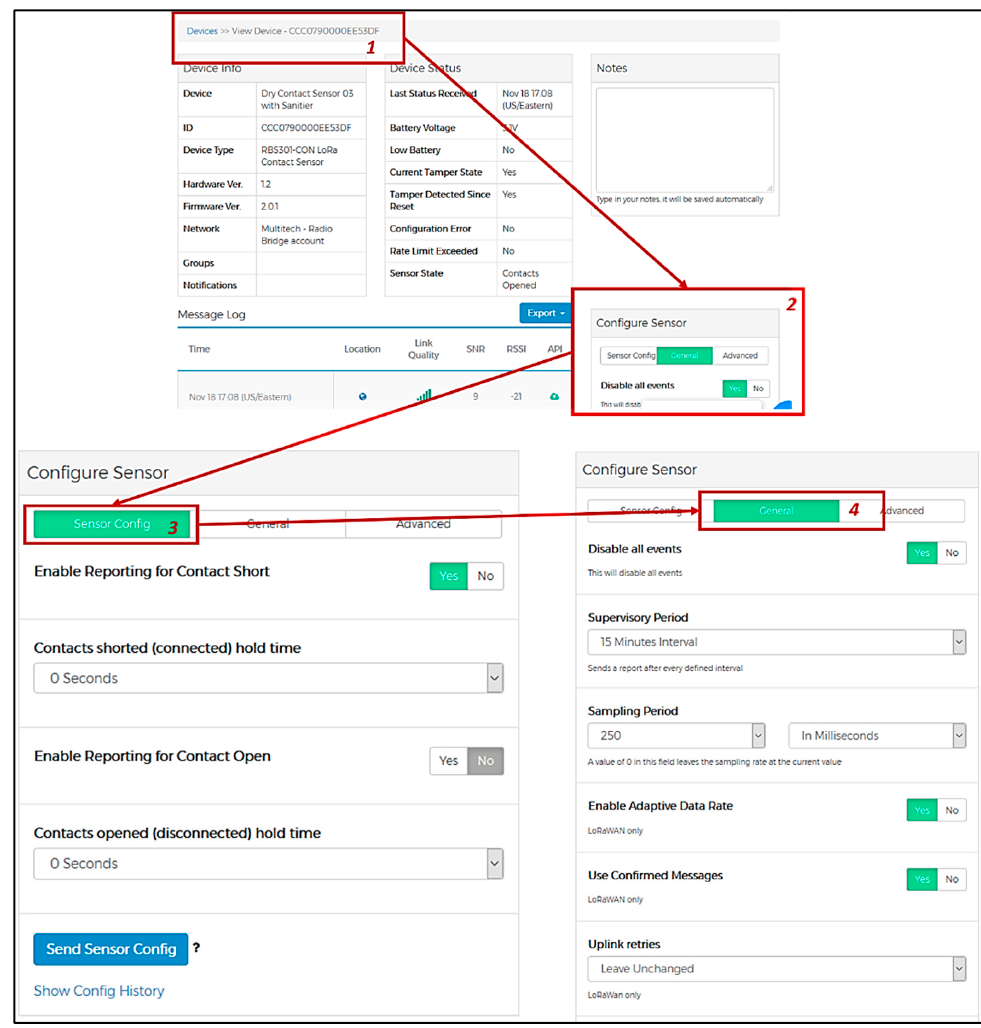
Figure 7. Sensor configuration in Radio Bridge Console.